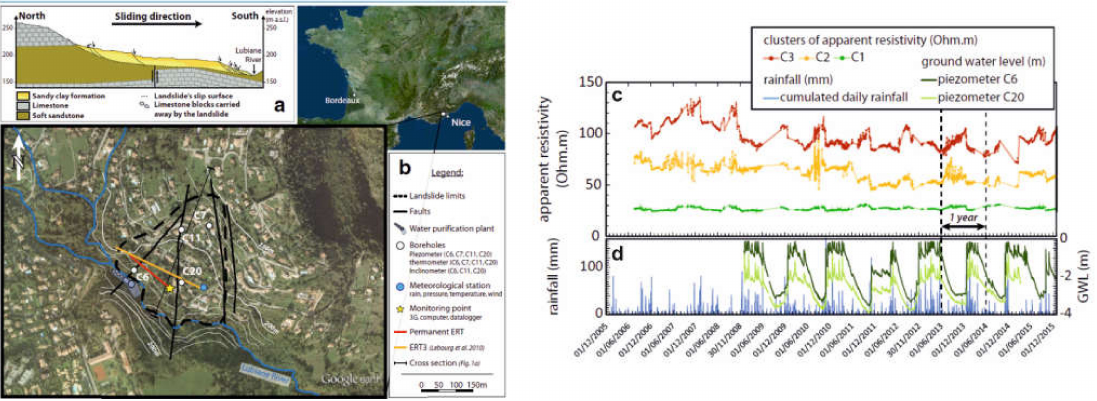
Figure 5. The map at the top reports the location of the survey carried out on the Vence landslide (south-eastern France), a simplified geological cross section ( a ) obtained along the sliding direction and the layout of the field survey carried out in the area. ( b ) Legend. The images below show ( c ) the variations of the daily median values of the three clusters of apparent resistivity measurements iden- tified for the slope in the period 2006–2016, and ( d ) the accumulated rainfall index and groundwater level obtained by direct measurements in C6 and C20 for the same period (after